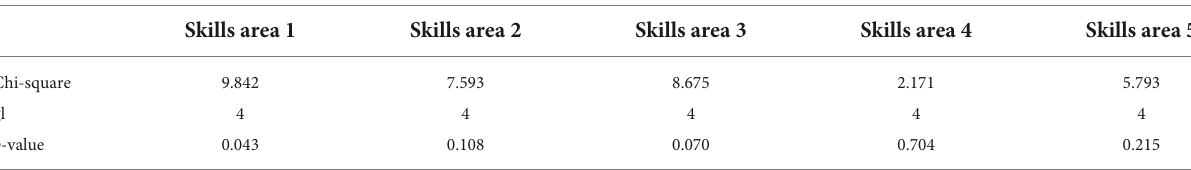
TABLE 9 Analysis of the association between mode of attendance and the level of digital skills.